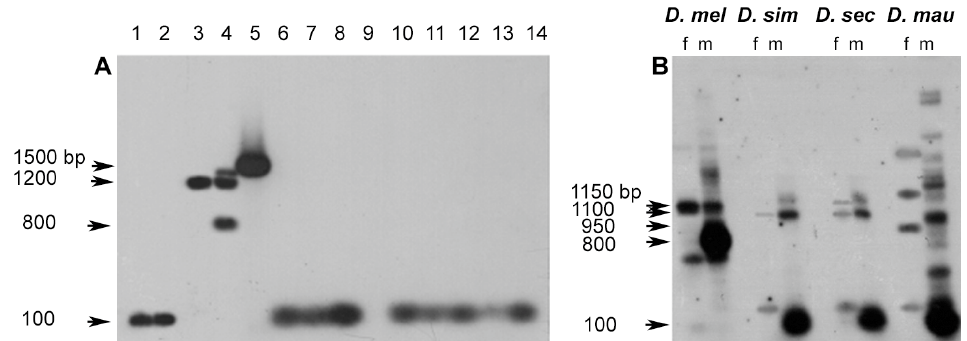
Figure 6. ( A ) Southern blotting analysis of lambda phage DNA, isolated from D. simulans library, digested with CfoI enzyme; hybridization of pUSTE6 probe identifies a fragment of 100 bp in most lambda phages, except in three. Phages loaded in lanes 2, 3, 4, and 5, named Ds λ F6, Ds λ F4, Ds λ F7, and Ds λ F20, respectively, were molecularly analyzed. ( B ) Southern blotting analysis of males (m) and females (f) genomic DNA of the indicated species, digested with CfoI enzyme, hybridized with a Ds λ F6 subclone (F6.3 clone).